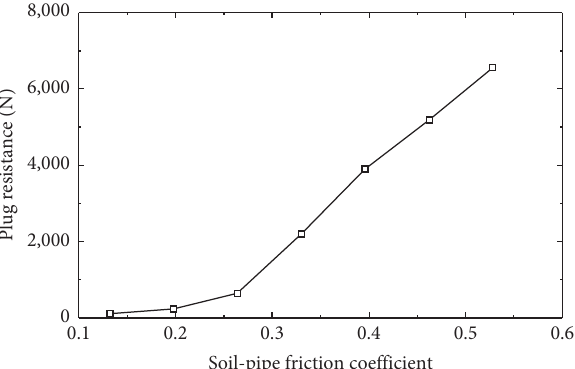
Figure 12: Soil plug resistance of numerical models with different soil-pile friction coefficients ( D � 10cm and L / D � 4.0).